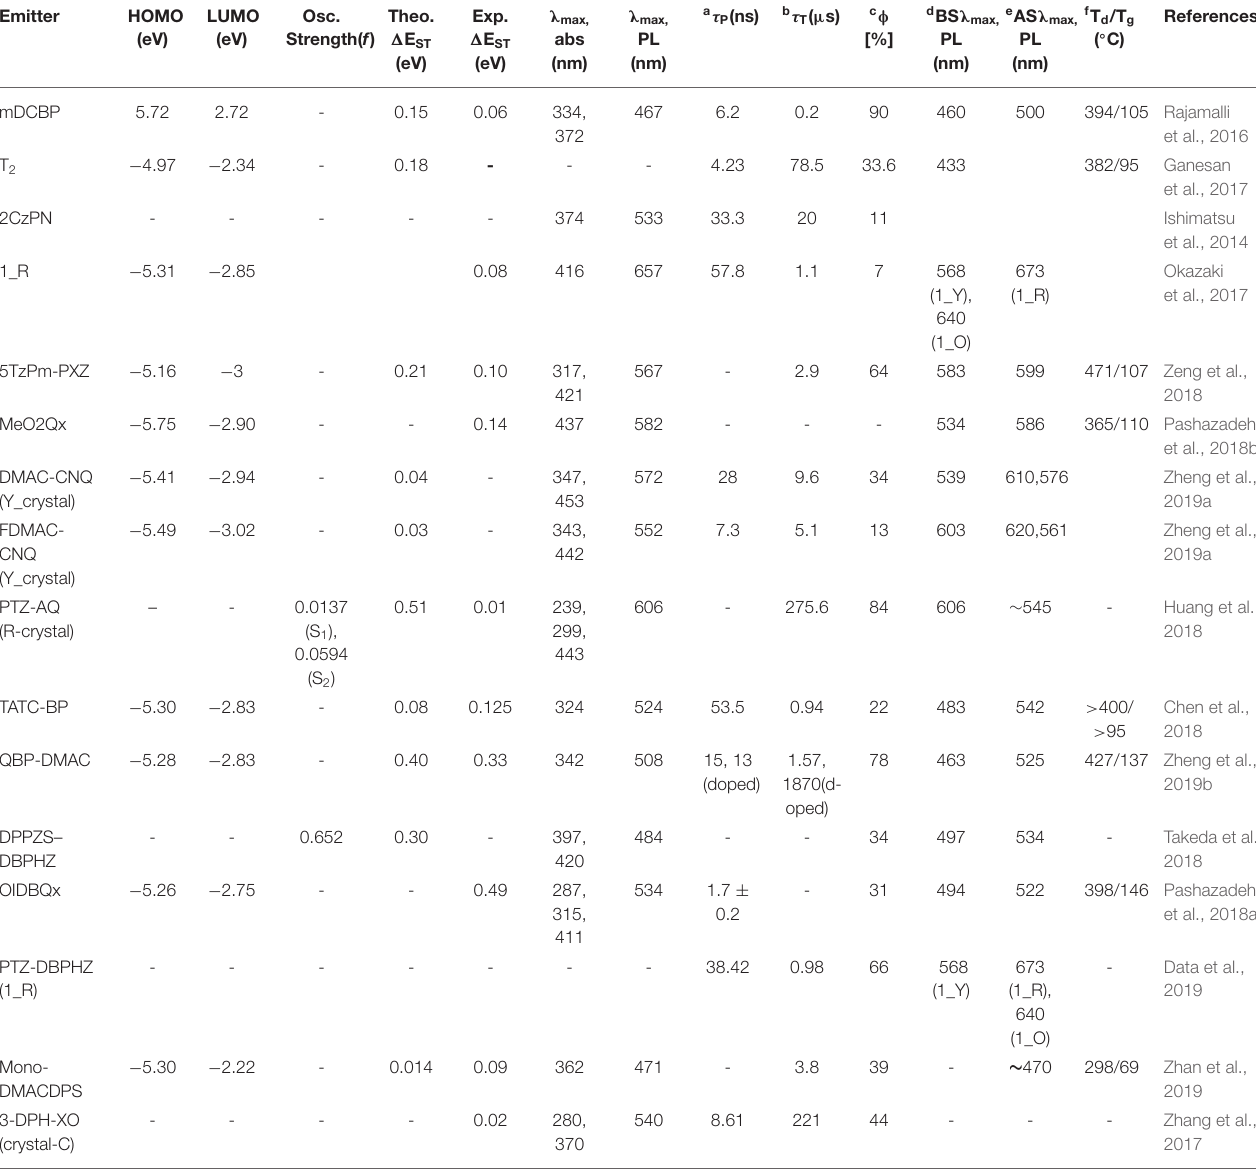
TABLE 1 | Computational and Photophysical characterizations of TADF-MCL